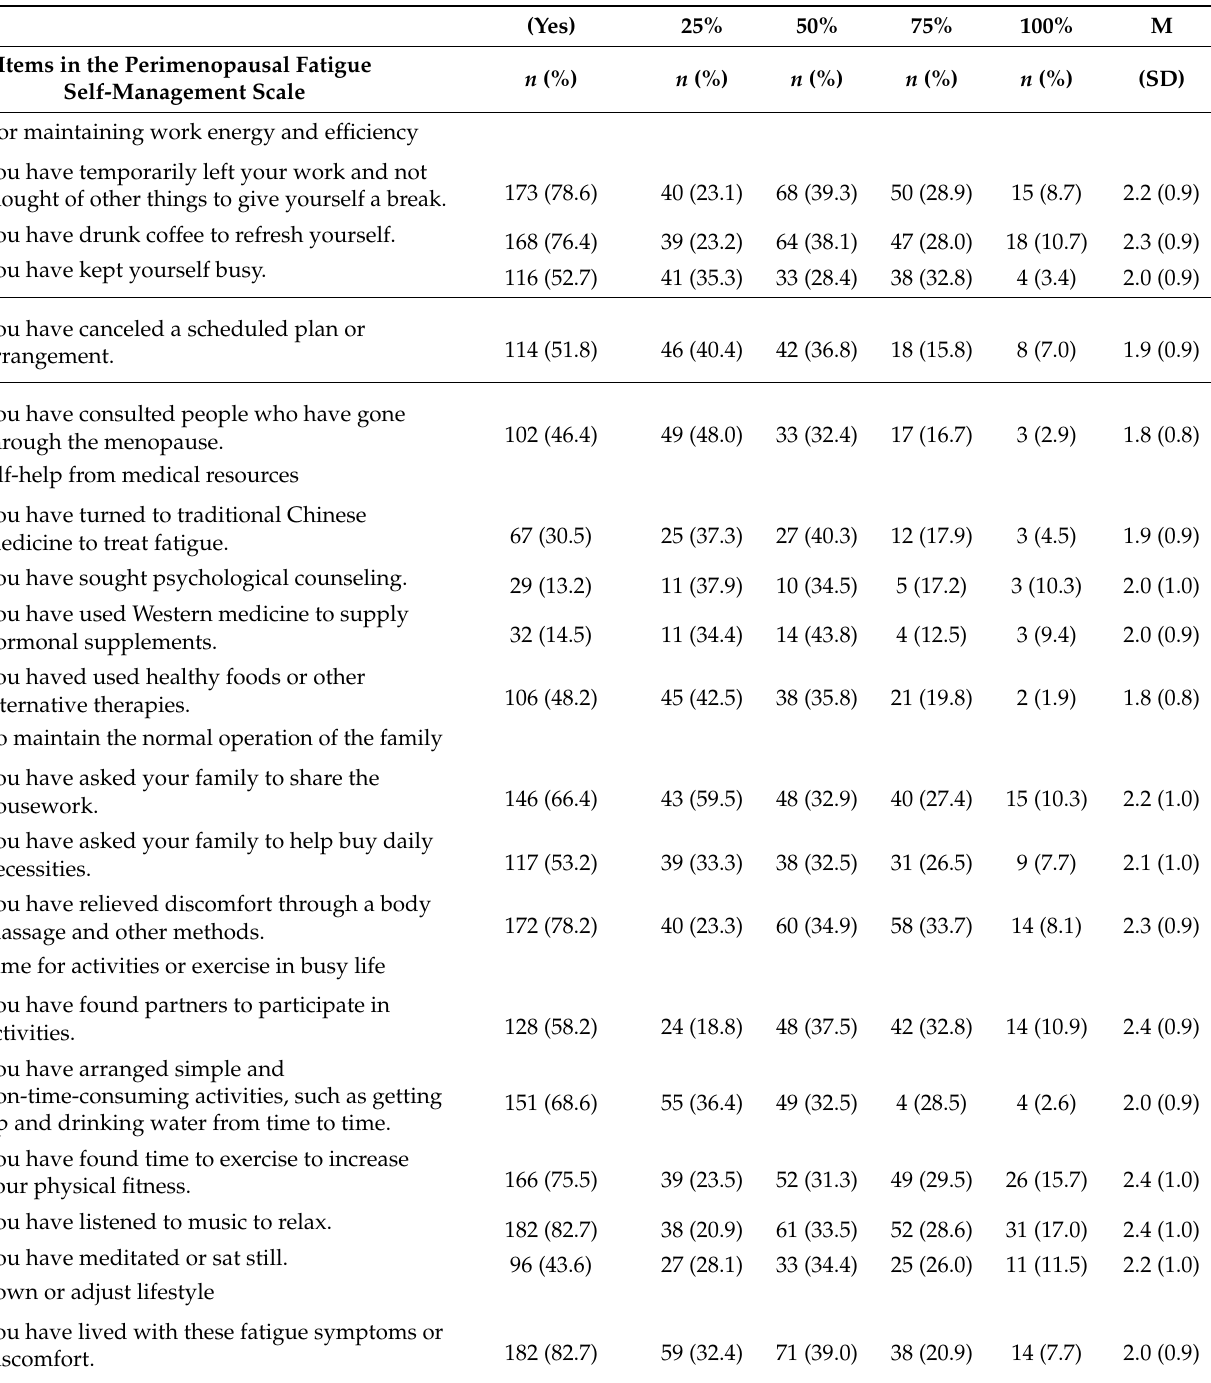
Table 4. Distribution of the “perimenopausal fatigue self-management scale” and “perceived validity” ( n =